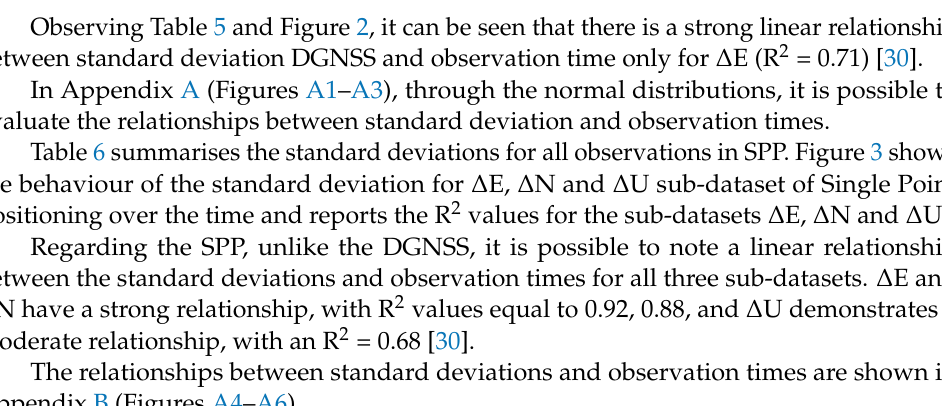
Figure 2. Linear regression between DGNSS standard deviation and observation time.